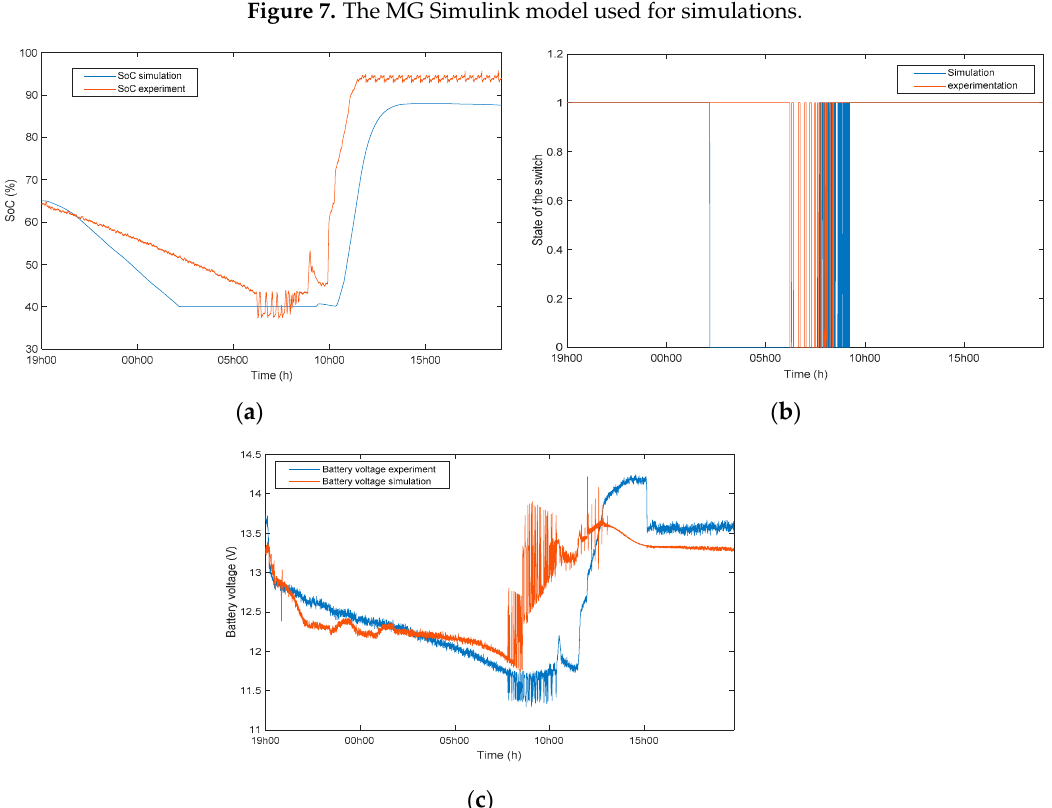
Figure 8. ( a ) The battery’s SoC; ( b ) The state of the relay (0: electric grid, 1: PV-Battery system); ( c ) The simulation and experimental battery’s voltage.